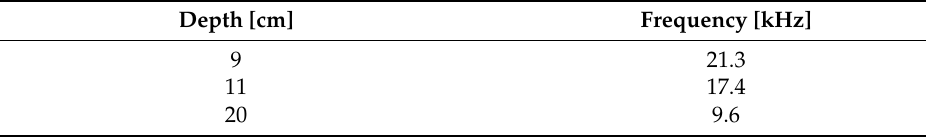
Figure 4. The plate with void: ( a ) view and ( b ) section. Table 1. Expected peaks for plate with voids ( C pp = 3834